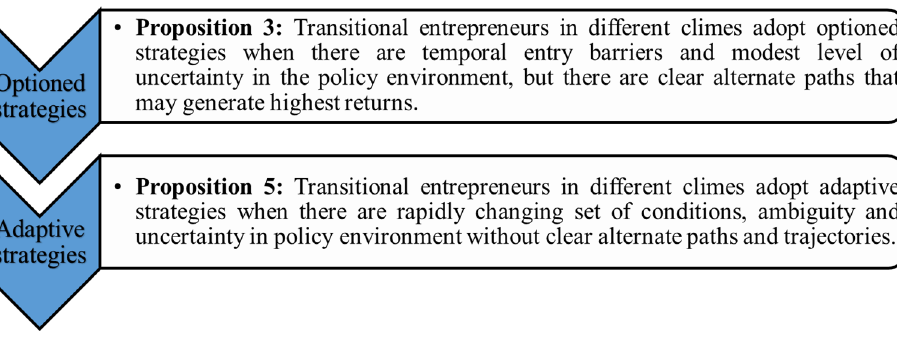
Figure 2. Propositions 3 and 5. Source: Authors’ elaboration.